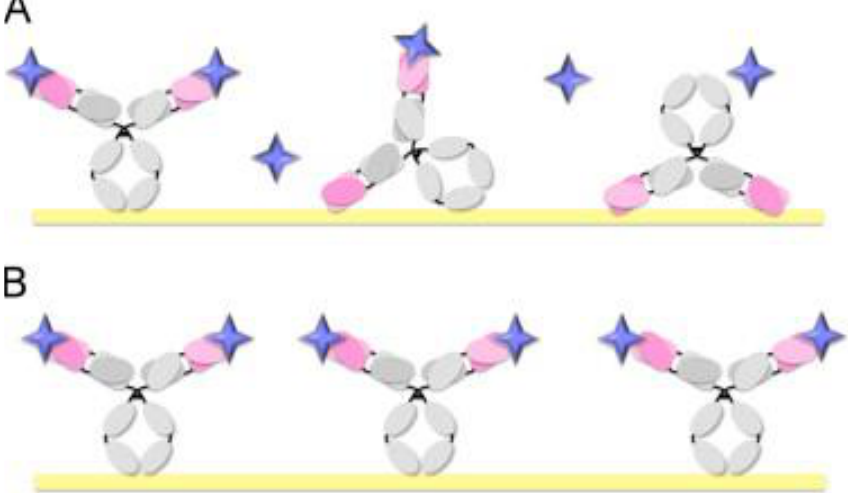
Figure 2. Two main approaches to antibody immobilization. ( A ) Random, and ( B ) site-directed